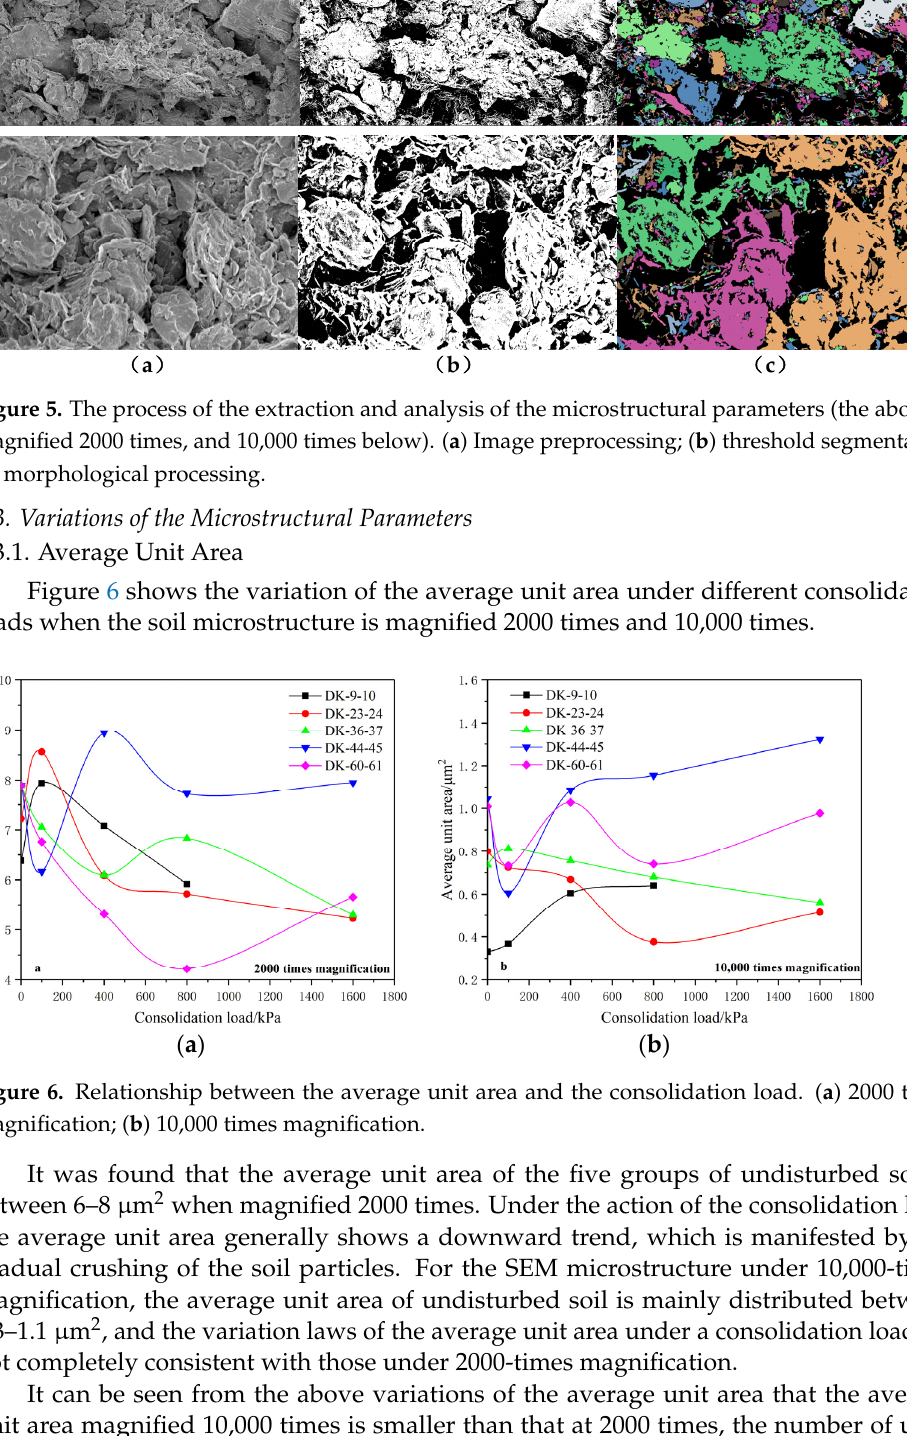
Figure 1. The main test procedures of samples microstructure scanning. (a) Samples preparation . (b) Freeze-drying. (c) Surface coating. (d) Scanning electron microscopy.